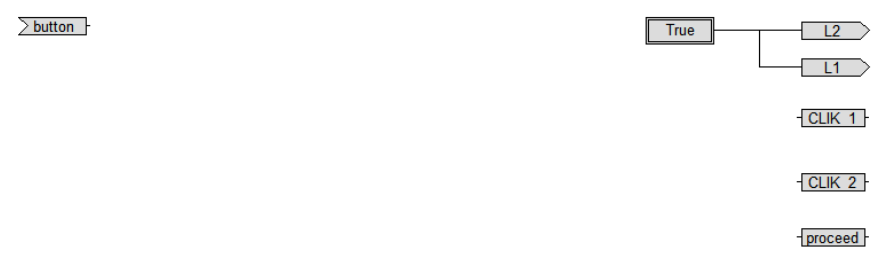
Figure 17. Data Flow of Step all_ON (normal case).